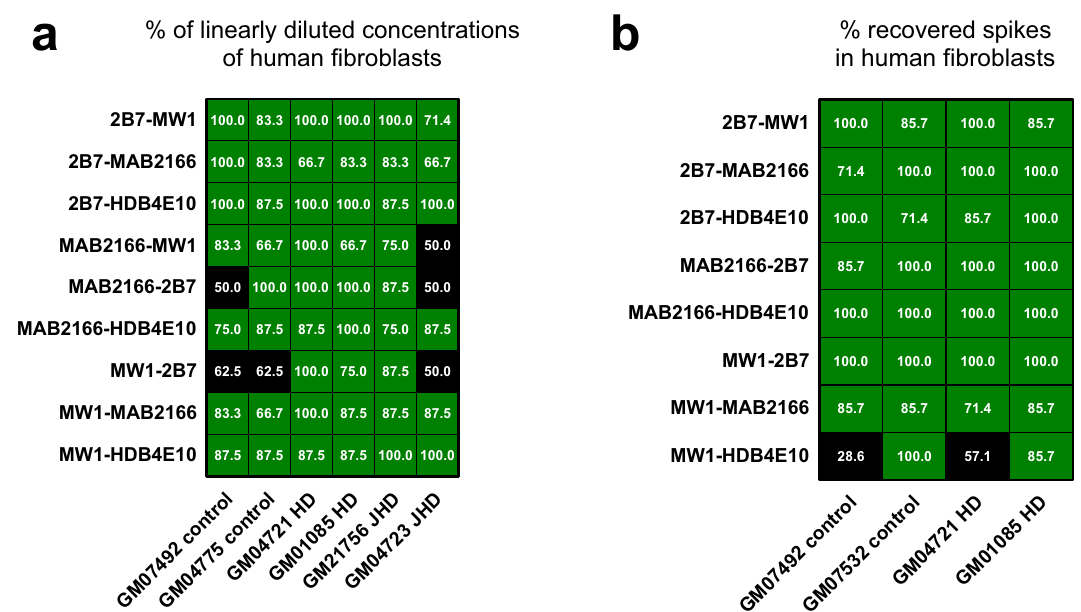
Figure 6. Dilution linearity and spike recovery in wild type, HD and JHD human fibroblast lysates. Black cells are antibody pairs that did not meet the 67% acceptance criteria (see text), green cells show antibody pairs with achieved dilution linearity and/or spike recovery. ( a ) Two control GM04775 (24/17) and GM07492 (21/18), two HD GM04721 (49/36) and GM01085 (45/23) and two JHD GM04723 (70/20) and GM21756 (66/18) fibroblast cell lysate were diluted for 7 dilution points and assayed via SMC using the antibody pair reported on the x-axis. The percentage of the dilution points within the ± 20% RE% is reported in each cell of the heat-map. The acceptance threshold is 66.7%; all conditions passing this threshold are coloured in green. All data for each matrix and each assay are reported in the supplementary figure S-7, calculations were carried out as reported for Fig. 4. ( b ) Two controls GM07492 (24/17) and GM07532 (23/19), two HD (GM0185 (45/23) and GM04721 (49/36) fibroblast lysate were spiked with a serial dilution of the recombinant FL HTT Q46 and assayed via SMC using the antibody pair reported on the x-axis. The percentage of the recovered spikes, within one matrix, is reported in each cell of the heat-map. The acceptance threshold is 66.7%; all conditions passing this threshold are coloured in green. All data for each matrix and assay are reported in the supplementary figure S-8.